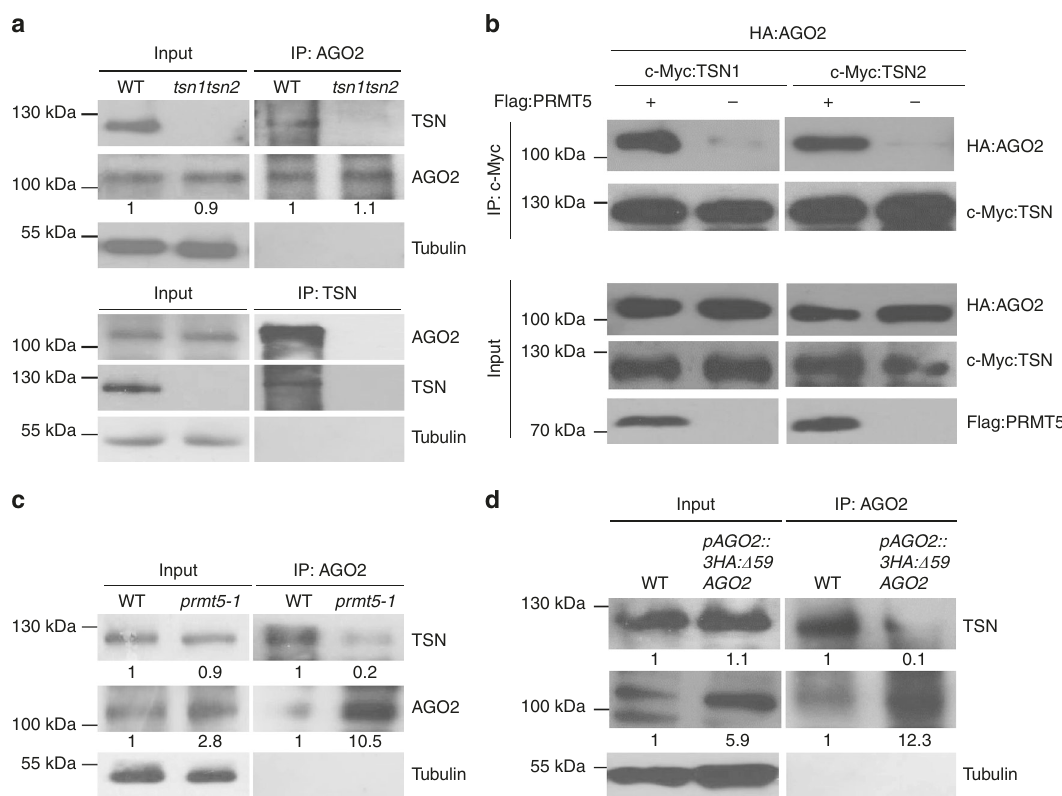
Fig. 4 Arabidopsis TSN proteins bind to arginine-methylated AGO2. a Interaction between TSNs and AGO2 was examined in Arabidopsis by co-IP assays. Native antibodies of TSN and AGO2 proteins were used for pull-downs and western-blot analysis. b PRMT5-directed arginine methylation mediates the interaction between AGO2 and TSN1 and TSN2 assayed by co-IP analysis. c TSNs interact with AGO2 in a PRMT5-dependent manner in Arabidopsis . d Arginine methylation in the AGO2 N -terminal region is essential for interactions with TSN proteins. Deletion of the N -terminal region largely reduced the binding with TSNs. Tubulin levels were used to show equal loading for all Western blots. In all panels, signal intensity was calculated using